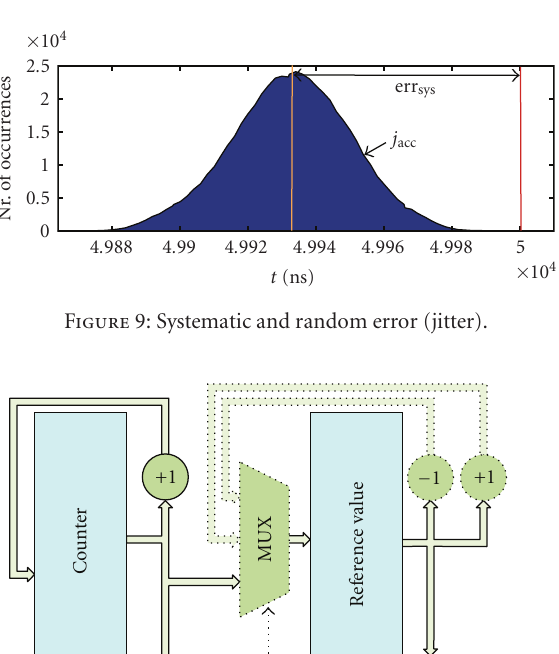
the receive-line of the TTP bus), as well as one output (ref-time, an asynchronously generated signal with known period). The dashed components and the MUX have